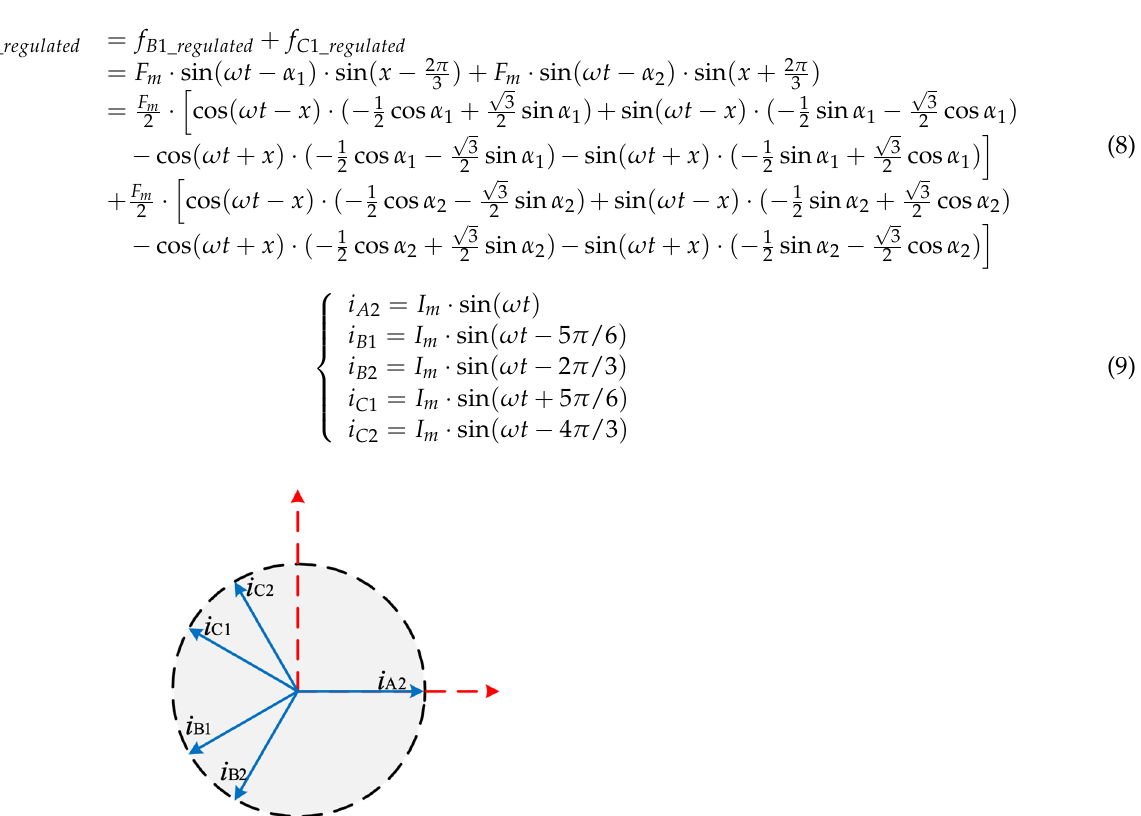
Figure 10. Phase diagram of regulated currents under one-phase open-circuit (phase A1 open-circuit) fault-tolerant control.